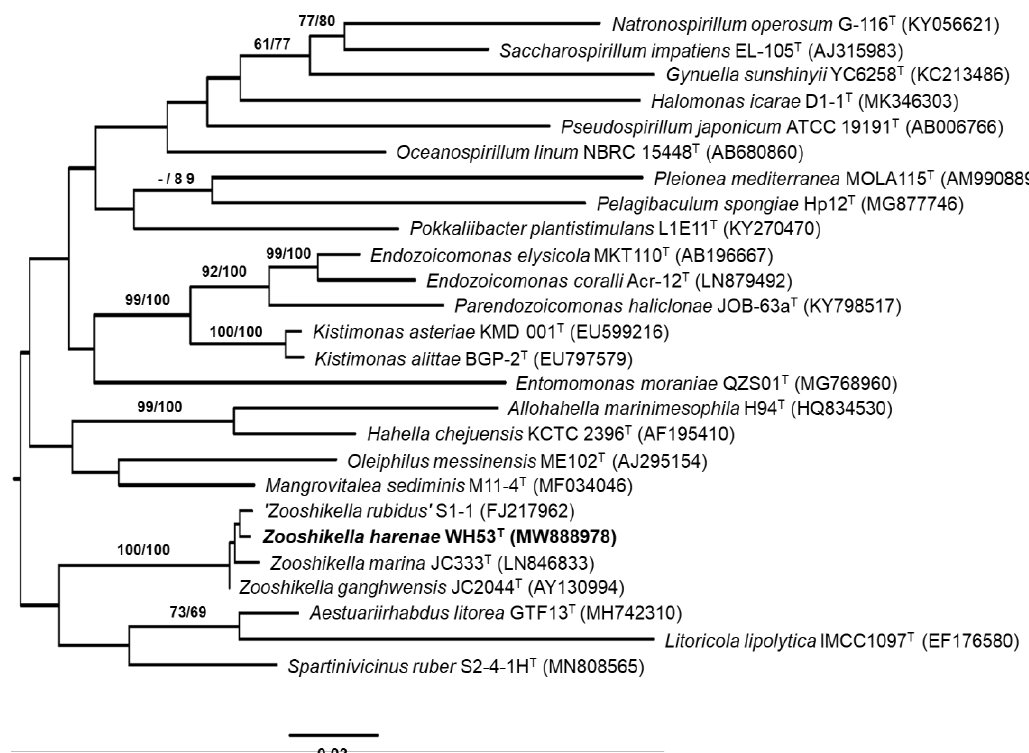
Figure 2. The GTR+GAMMA model was used to infer the ML tree, which was then rooted using midpoint-rooting. The branches were scaled in terms of the expected number of substitutions per site. The numbers above the branches represent the support values obtained from ML (left) and MP (right) bootstrapping. They were meaningful more than 60%. After 1000 replicates, the ML bootstrapping converged, with an average support of 59.57%. MP analysis yielded the best score of 1942 (consistency index 0.41, retention index 0.44) and two best trees. The MP bootstrapping average support was 64.04%.